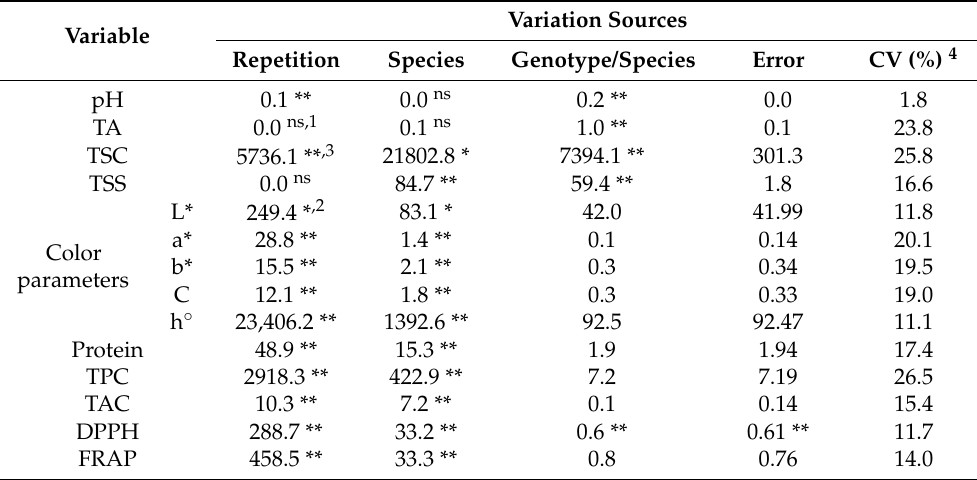
Table 1. Mean square values of the variance analysis of the physicochemical parameters in green